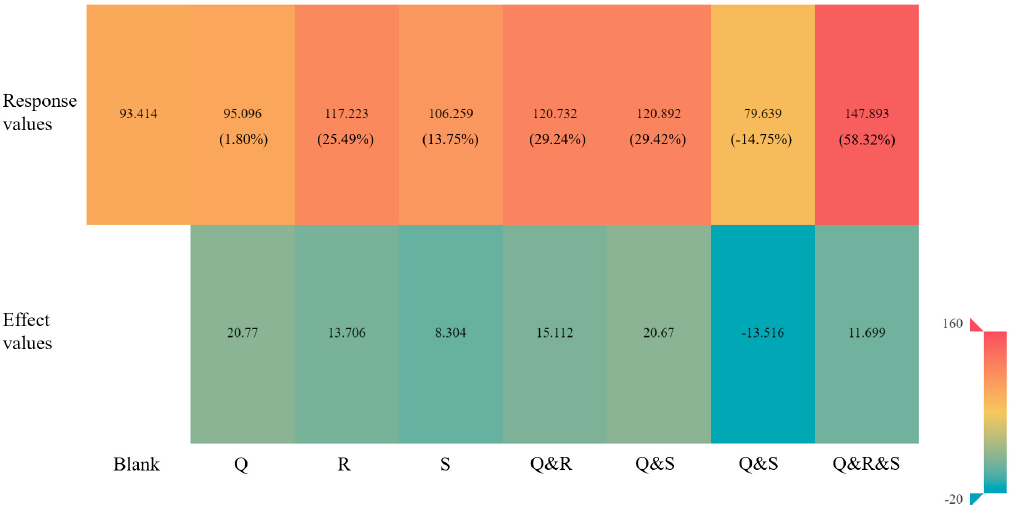
Figure 2. Response and effect values for the 8 external conditions schemes (3-factors/2-levels).